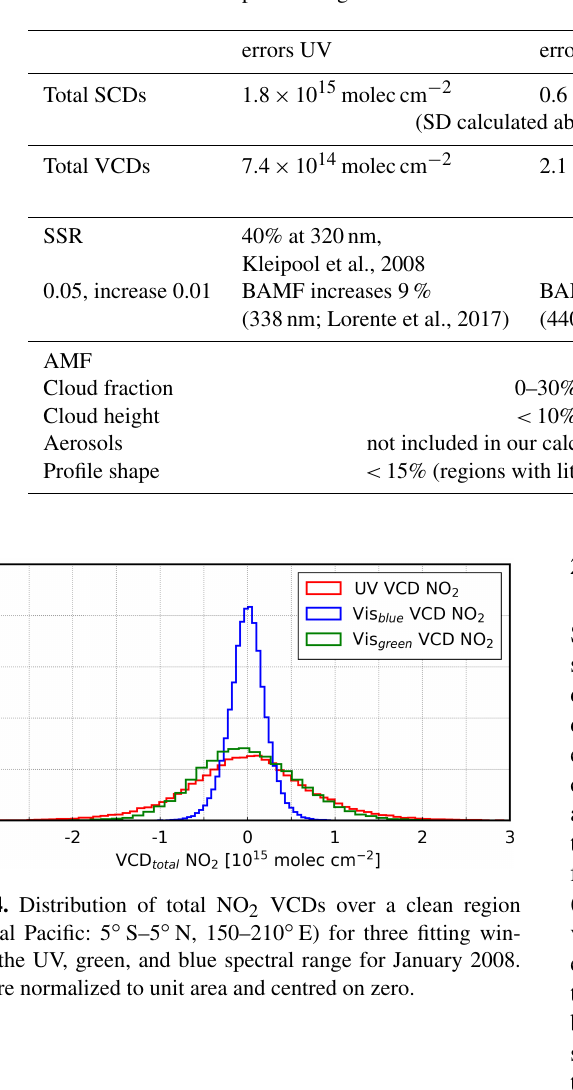
Figure 3. The NO 2 reference (differential NO 2 cross section multiplied by retrieved NO 2 SCD; solid line) and reference plus residual (dashed line) for the (a) UV, (b) blue, and (c) green spectral range for one pixel above Teheran (35.38 ◦ N, 51.47 ◦ E) on 22 January 2008. The SCD for this pixel for the UV spectral range is 6.31 × 10 16 moleccm − 2 with a fit error of 4.3%, for the blue spectral range it is 9.33 × 10 16 moleccm − 2 with a fit error of 0.8%, and for the green spectral range it is 9.88 × 10 16 moleccm − 2 with a fit error of 0.9%. Note the different y axes. Table 2. Errors for the UV and vis spectral range.